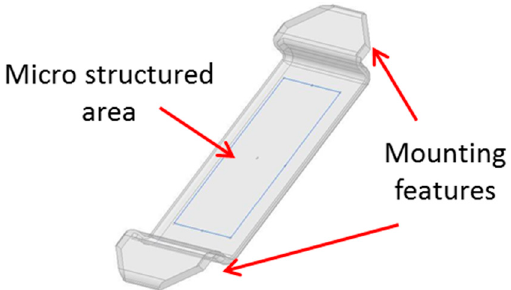
Figure 1. Design of the polymer MLA with the microstructured area and mounting features.